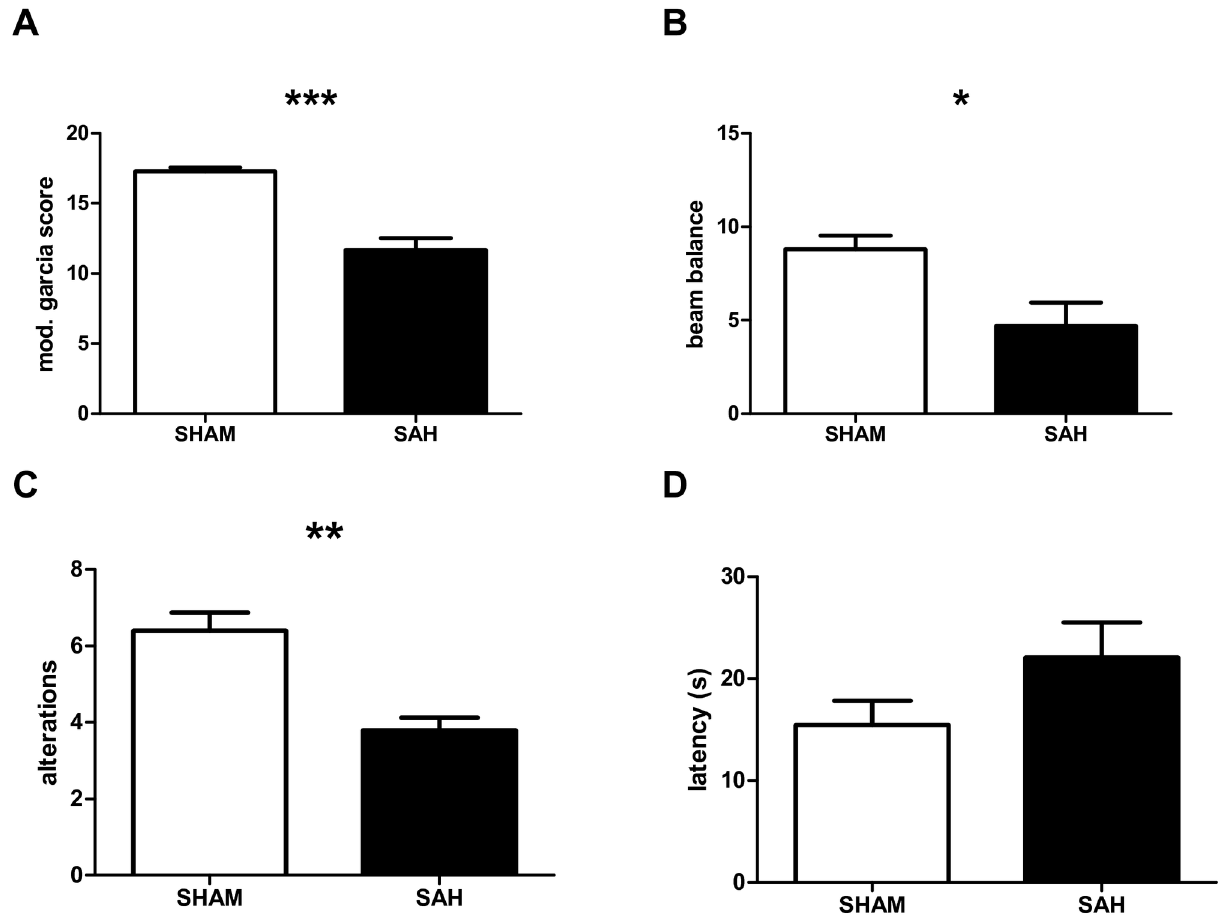
Figure 1. Neurobehavioral scores. Neurobehavioral scores 24 hours (A, B) and 21 days (C, D) after SHAM or SAH surgery respectively. Modified Garcia score (A), sum score of three consecutive trials of beam balance test (B), number of alterations in T- maze test (C) and mean latency to decision in seconds in T-maze test (D). Mean and SEM is shown. * p<0.05, ** p<0.01, ***